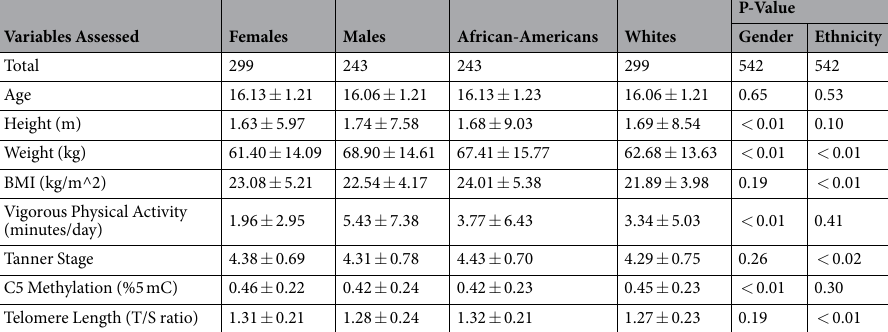
Table 1. General characteristics of study participants by gender and ethnicity.